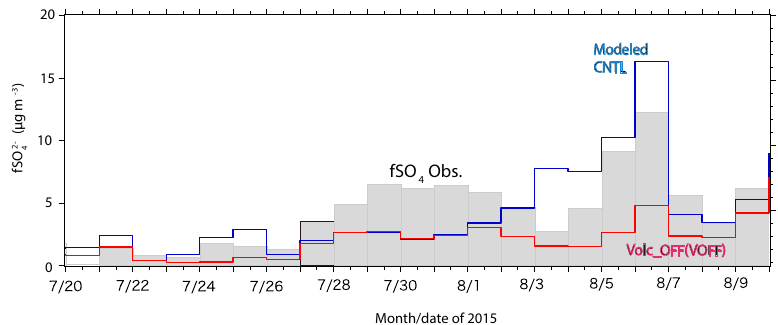
Figure A2. Daily average variation in observed (gray shading) and modeled fine SO 2 −